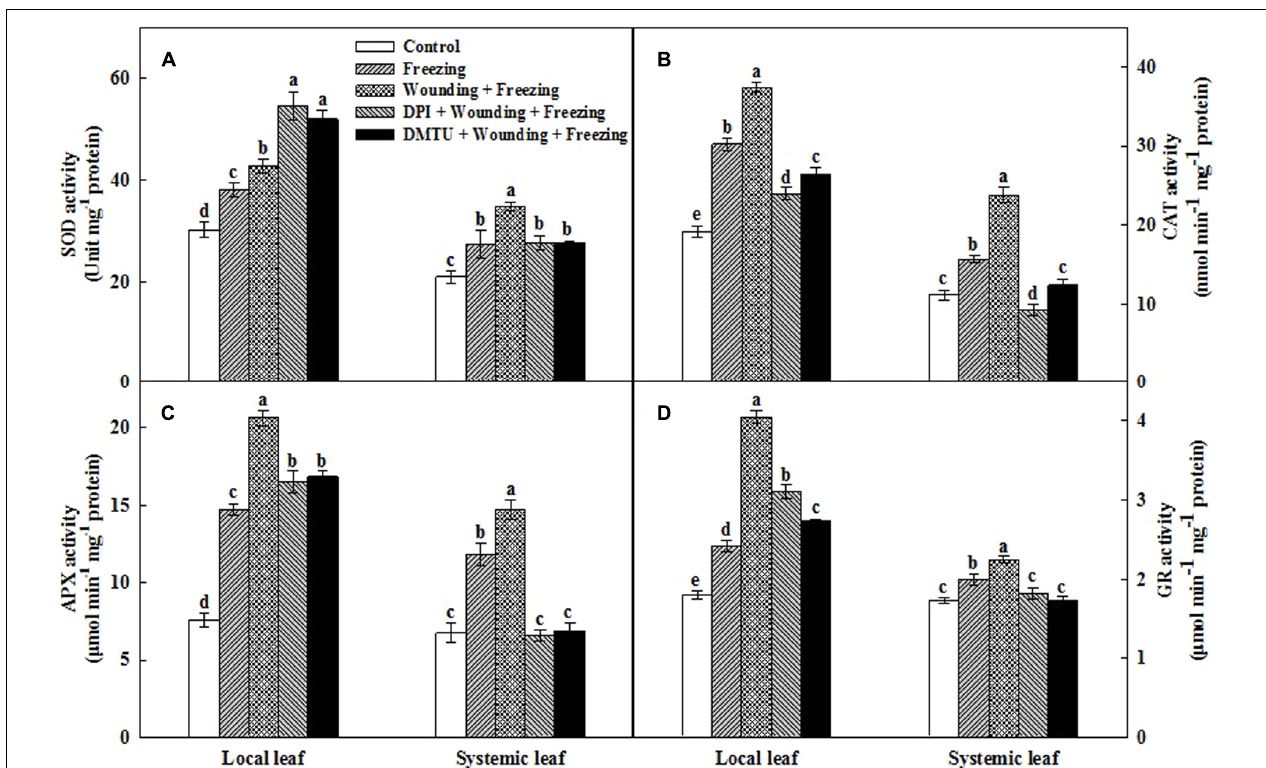
FIGURE 6 | Effect of mechanical wounding on activities of the antioxidant enzymes in the local and the systemic leaves of wheat under freezing stress. Activities of superoxide dismutase (SOD) (A) , catalase (CAT) (B) , ascorbate peroxidase (APX) (C) , and glutathione reductase (GR) (D) . The local (fifth) leaves were separately pre-treated with distilled water, 5 mM DMTU or 100 µ M DPI prior to wounding. At 10 days after wounding, the seedlings were exposed to freezing stress for 24 h. After 24 h recovery, both local and systemic (sixth) leaves were collected for the measurement. Data are mean values ± SD for three independent replicates. Means denoted by different letters indicated significant difference at P < 0.05 according to Tukey’s